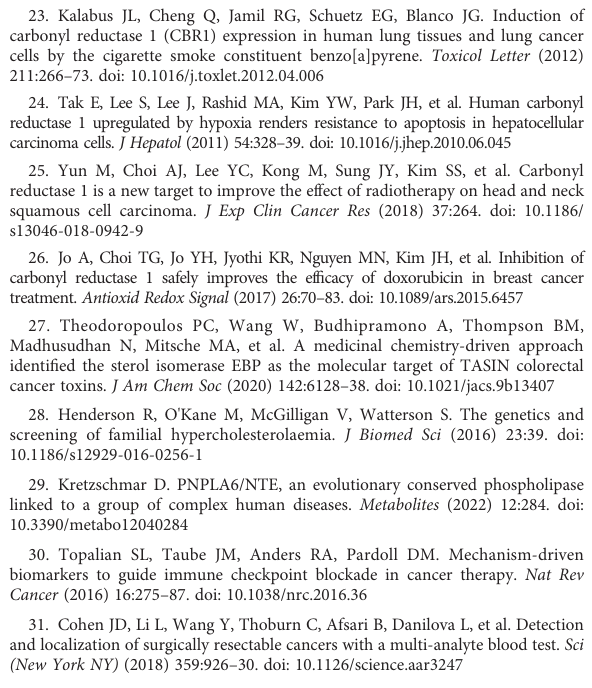
SUPPLEMENTAL FIGURE 2 The predictive value of the signature in other cancers. Survival analysis in the two risk groups based on the signature in different types of cancers. SUPPLEMENTAL FIGURE 3 Correlation of each signature gene and prognosis. Survival analysis in the two subgroups of patients classi fi ed by the expression level of each gene in the signature.